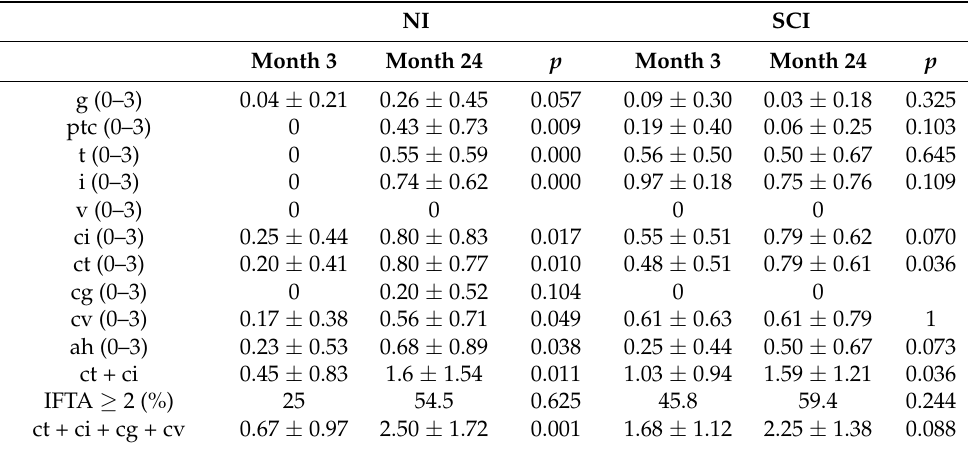
Figure 3. Changes in chronicity scores from 3 to 24 months in both study groups in patients with SCI at the 3-month protocol biopsy, excluding patients with isolated mild inflammation without tubulitis (i1, t0) ( n = 22). Table 6. Overall changes in both acute inflammatory and chronicity scores from 3 to 24 months in patients with NI ( n = 36) and SCI ( n = 39) at the 3-month protocol